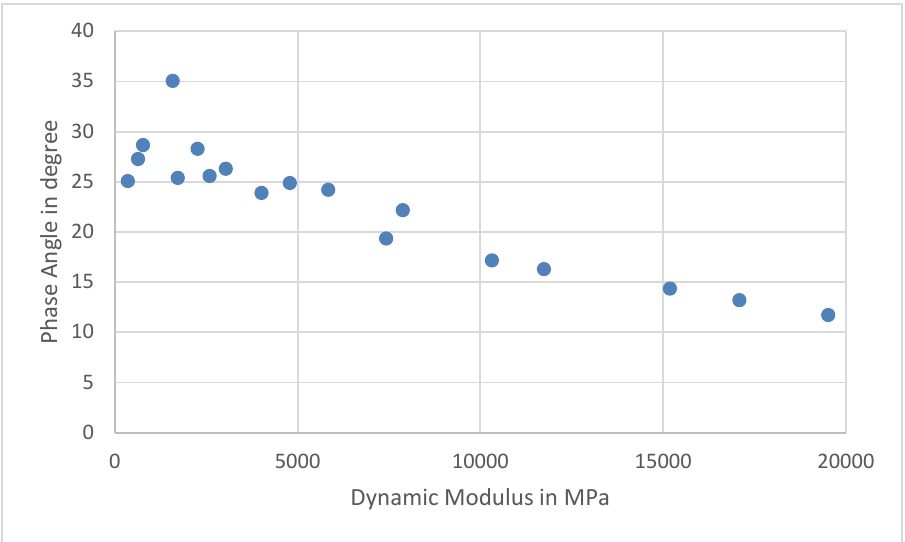
Figure 9. Black plot of SFP specimen (dynamic modulus vs. phase angle).